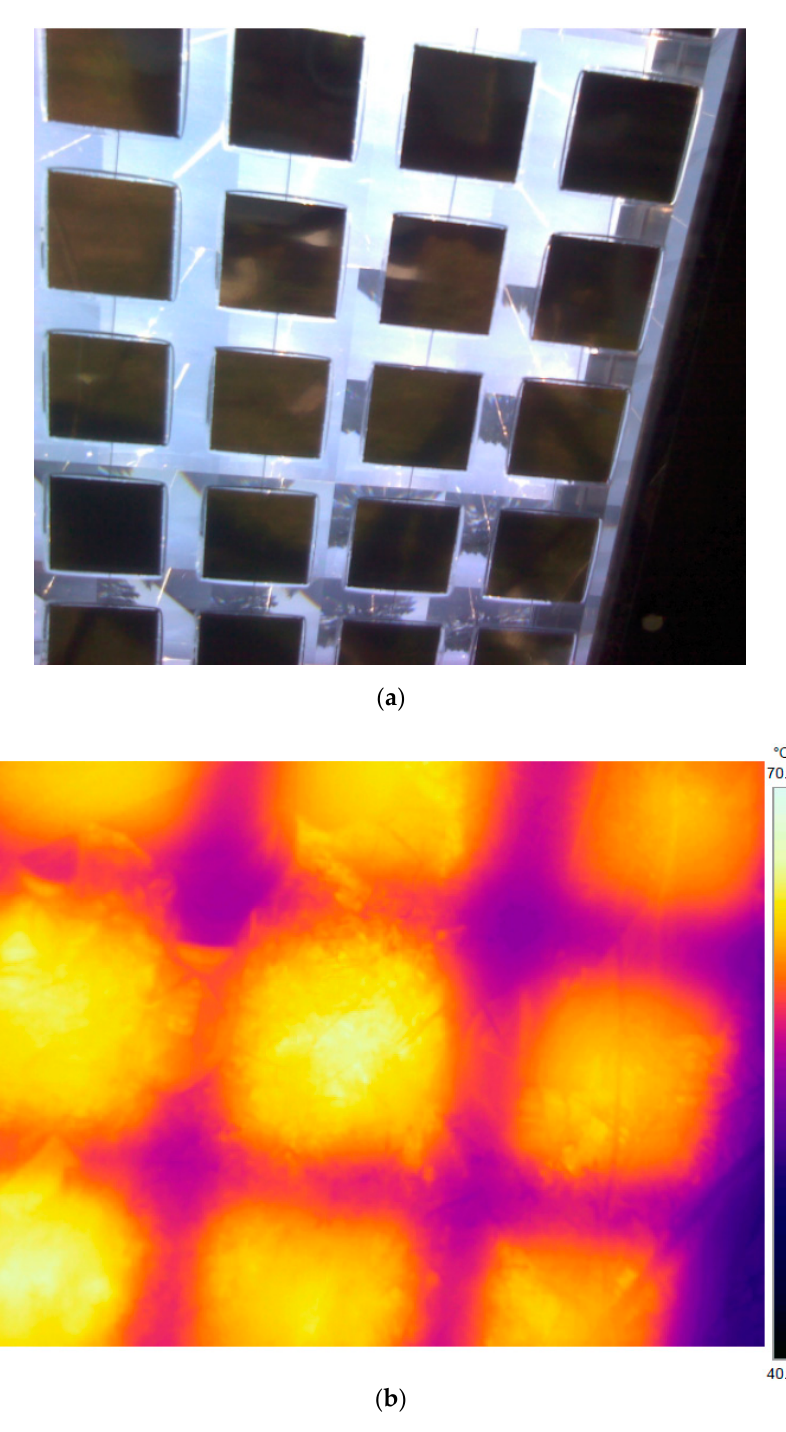
Figure 8. The back of CPV module ‘B’ in visible radiation ( a ) and in infrared radiation ( b ).